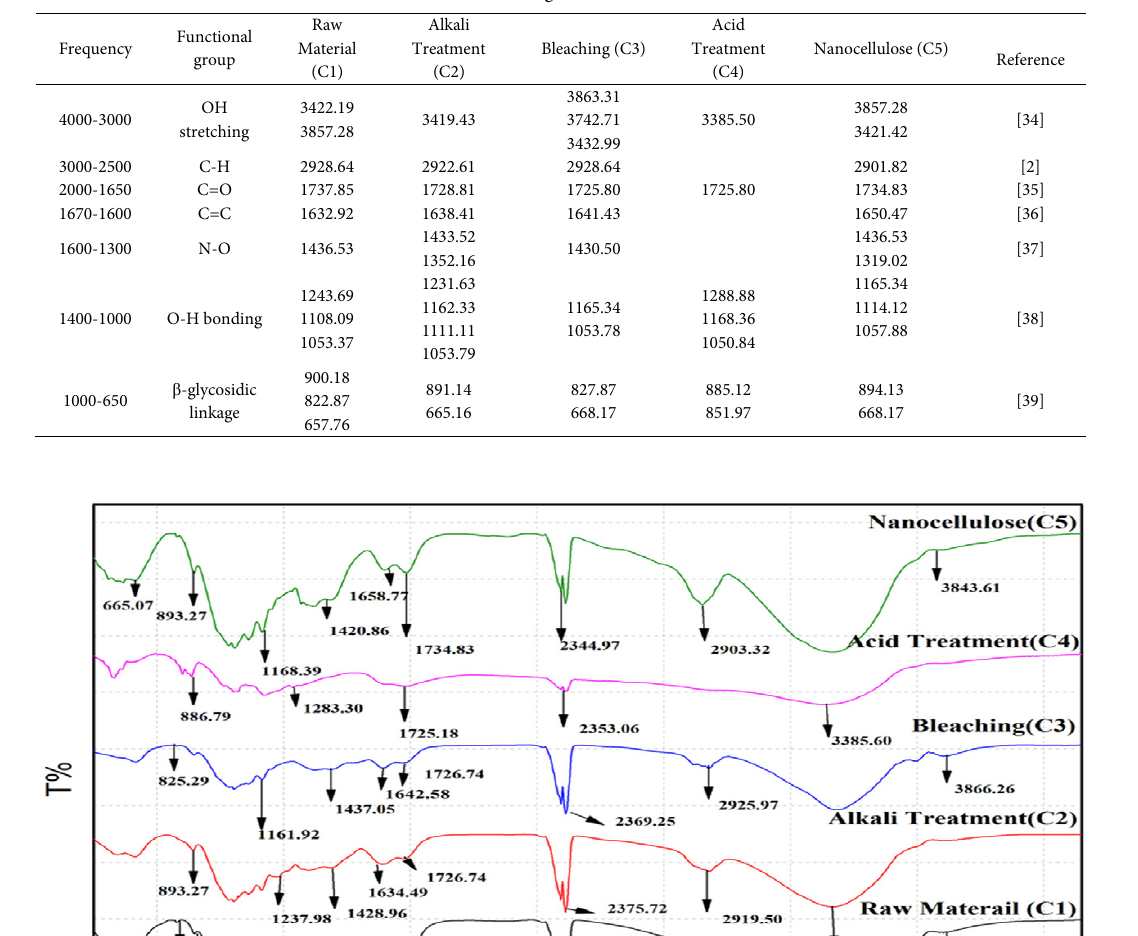
Table 2. FTIR Reading of Cotton Straw Material